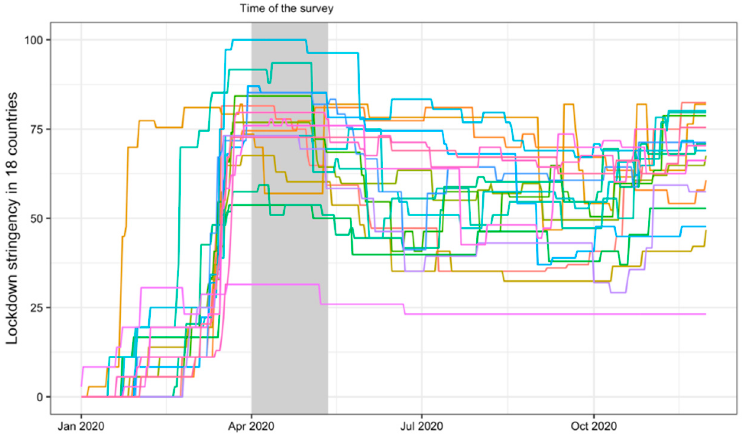
Figure 1. Governmental lockdown stringency index including the assessment period (Table 1 for more exact data). Note that due to the large number of countries, the data for individual countries can be viewed here: https://ourworldindata.org/grapher/covid-stringency-index (accessed on 1 November